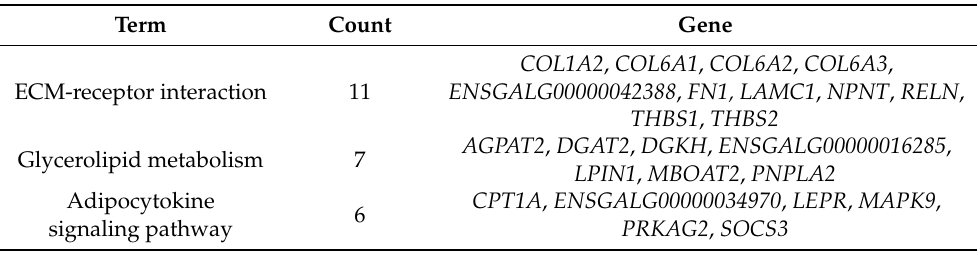
Table 2. Significantly enriched KEGG pathways are potentially related to muscle quality and meat flavor.